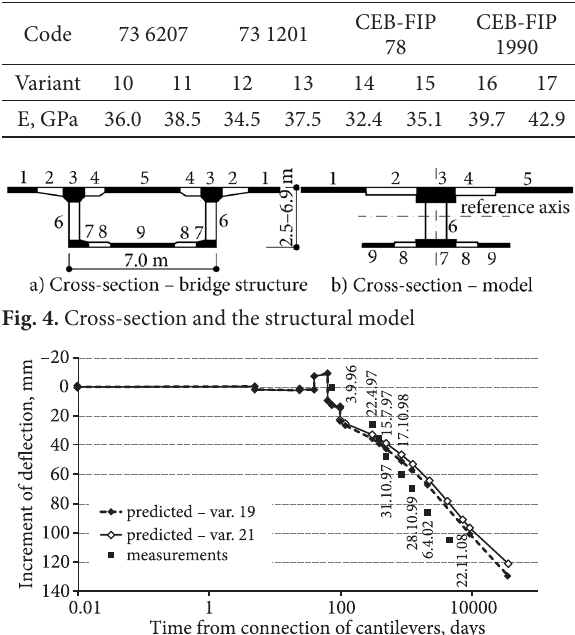
table 2. Moduli of elasticity for various rheological models